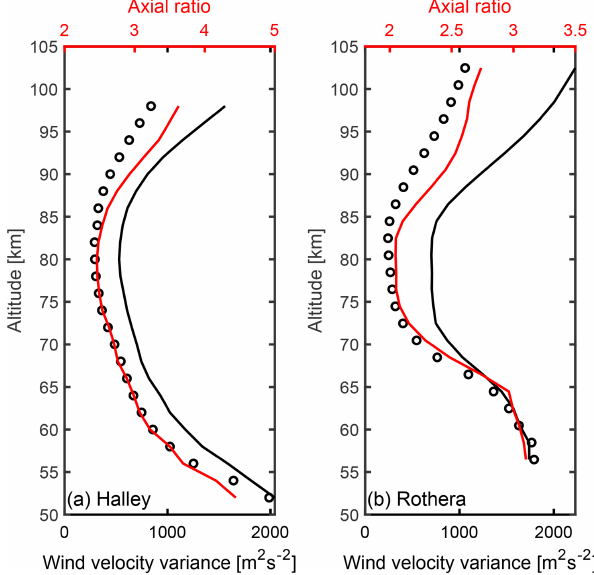
Figure 6. Vertical profiles of observed hourly variance in zonal wind data, excluding velocities over 150ms − 1 (black), the ex- pected hourly variance based on the observed number of outliers (black circles) and the mean axial ratio